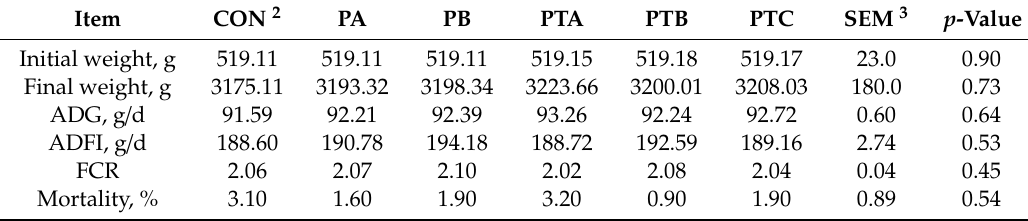
Table 3. E ff ects of di ff erent protease or phytase on growth performance in ducks 1 .